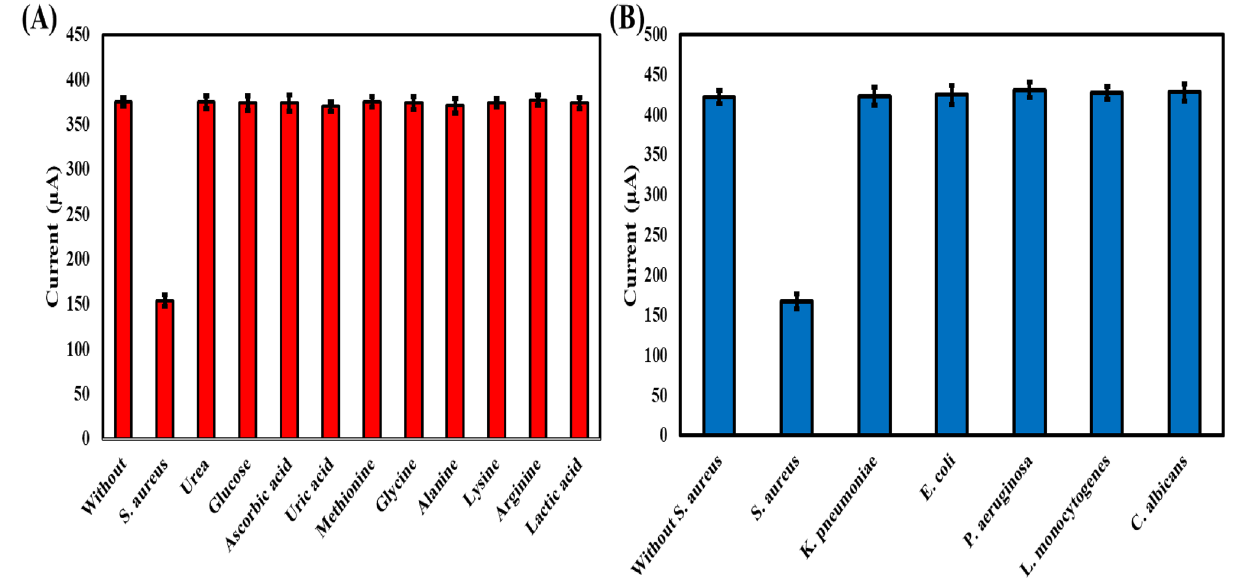
Figure 5. ( A ) CV scans of MIP-apt-AuNPs@ Fe 3 O 4 /GCE in presence of 10 3 CFU mL −1 S. aureus and 300 µM some common organic compounds in 0.1 M phosphate buffer containing 5.0 mM [Fe(CN) 6 ] 3−/4− at ν = 300 mV s −1 . (B) CV scans of MIP-apt-AuNPs@ Fe 3 O 4 /GCE in presence of 10 3 CFU mL −1 S. aureus and 10 6 CFU mL −1 interfering bacteria in 0.1 M phosphate buffer containing 5.0 mM [Fe(CN) 6 ] 3−/4− at ν = 300 mV s −1 .